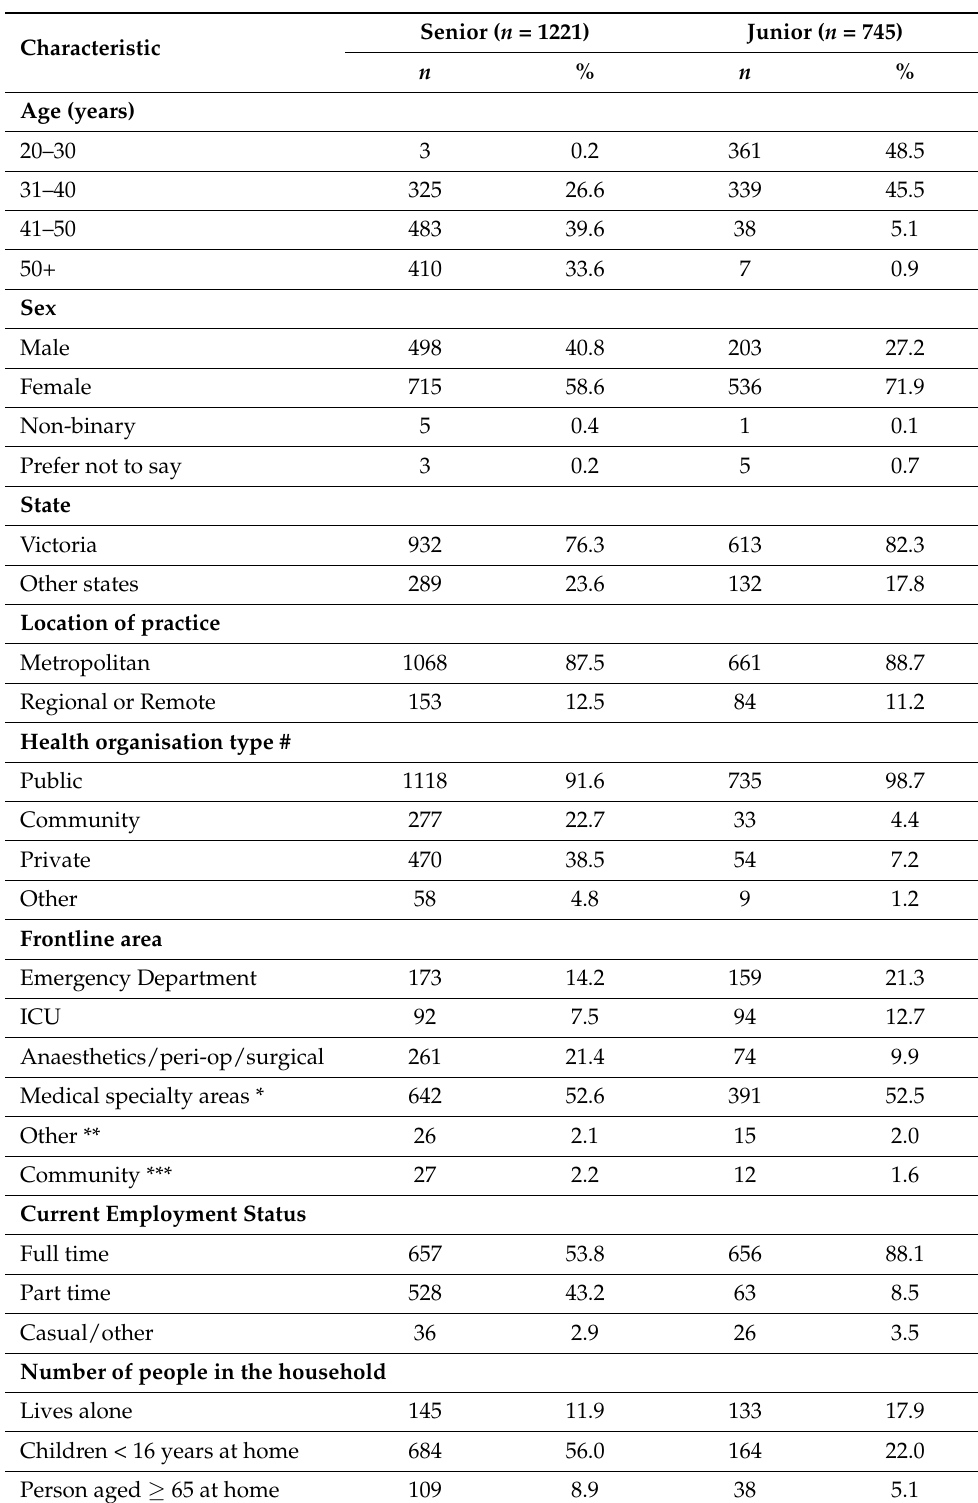
Table 1. Doctors’